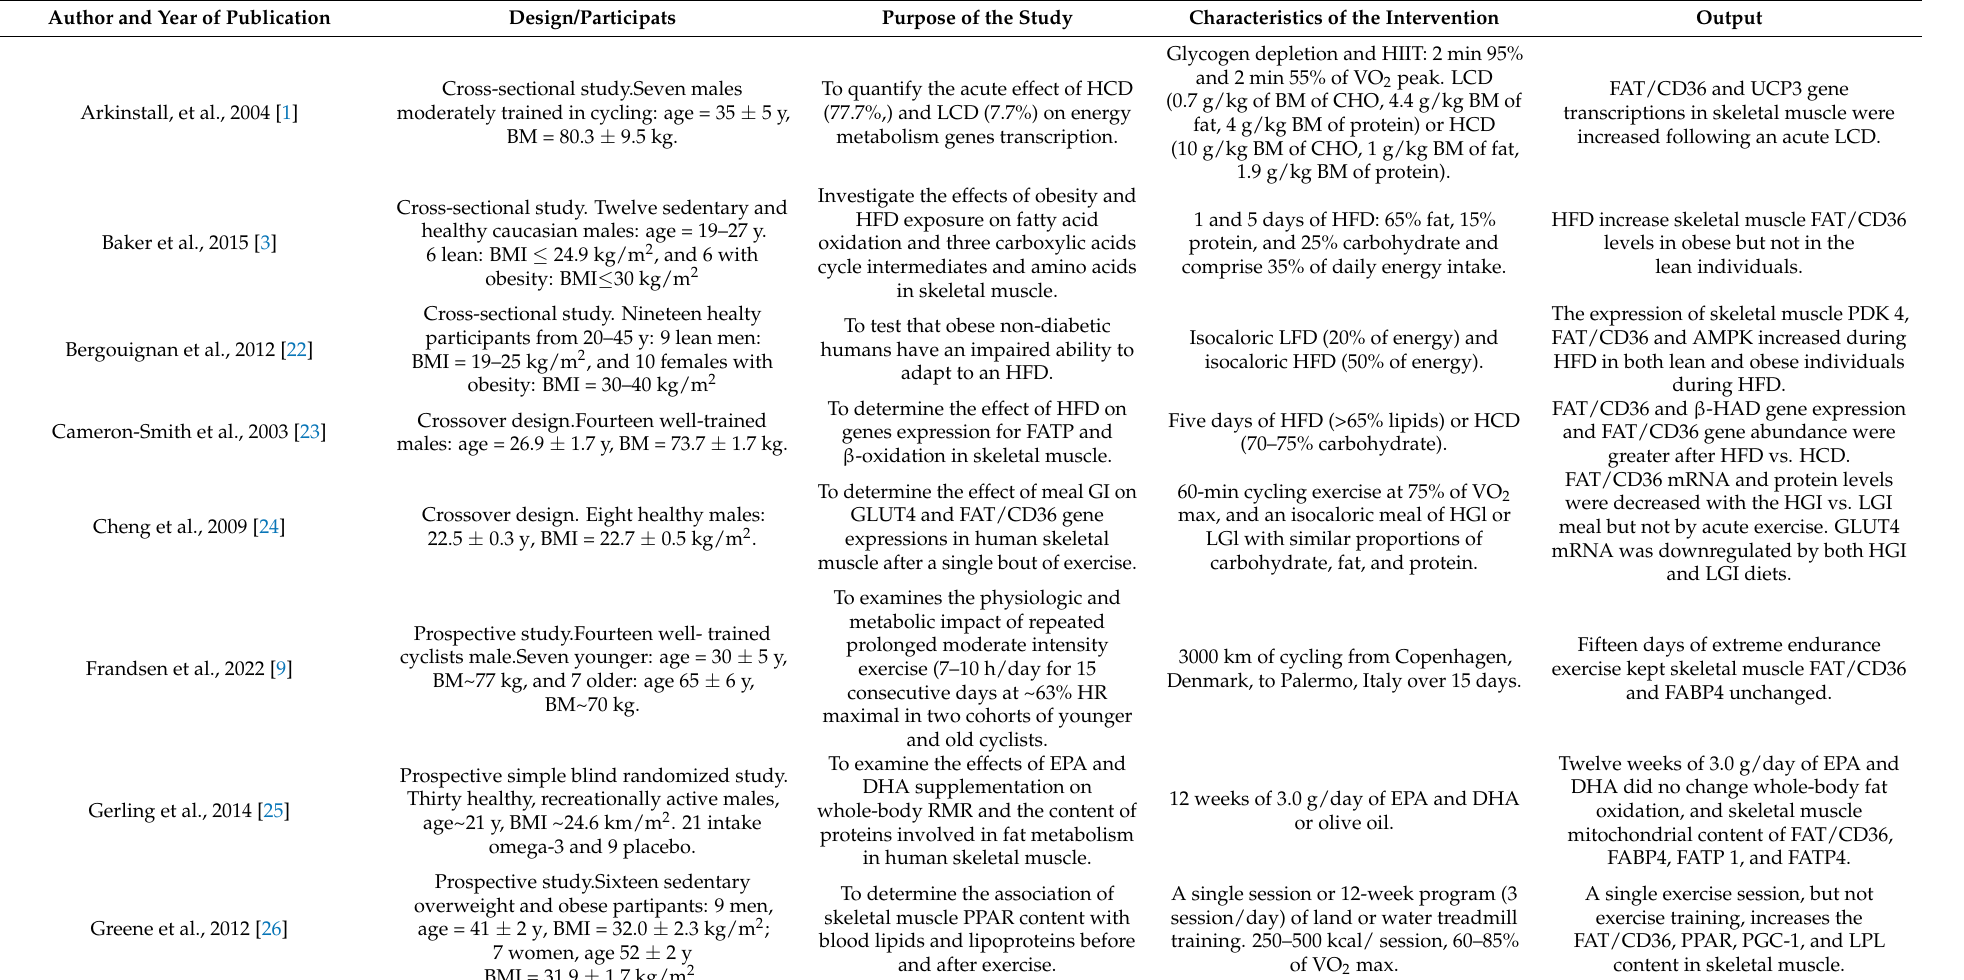
Table 1. Selected manuscripts according to the inclusion and exclusion